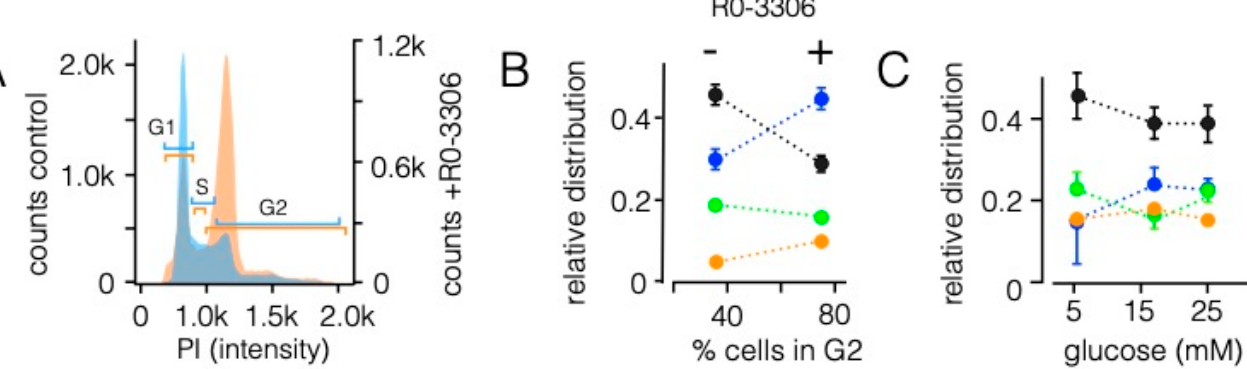
Figure 6. Sorting pattern of the Kesv channel in HEK293 cells is affected by cell cycle. ( A ) Analysis of DNA content in HEK293 cells by flow-cytometry in the absence and presence of cell cycle blocker R0-3306. Representative histograms of control cells (blue) and cells pretreated for 48 h with 7 µ M RO-3306 (red) as function of Propidium Iodide (PI) intensity. The respective cell cycle phases are indicated by colored bars. ( B ) Relative distribution (± SD, n = 3, n ≥ 150 cells) of Chimera C1 in mitochondria (black), SP (blue), dual location in mitochondria and SP (green) as well as non-sorted channels (orange) as a function of cells in G2 in control cells (36 ± 3%) and RO-3306 treated cells (74 ± 1.5%). Cells were transfected 24 h after exposure to inhibitor and imaged 24 h later. ( C ) Mean relative distribution (± SD, n = 3, n ≥ 120 cells) of Kesv channel in mitochondria (black), SP (blue), dual location in mitochondria and SP (green) as well as non-sorted channels (orange) in HEK293 cells transfected with Chimera C1. Cells were supplied in culture medium with the indicated concentrations of glucose.